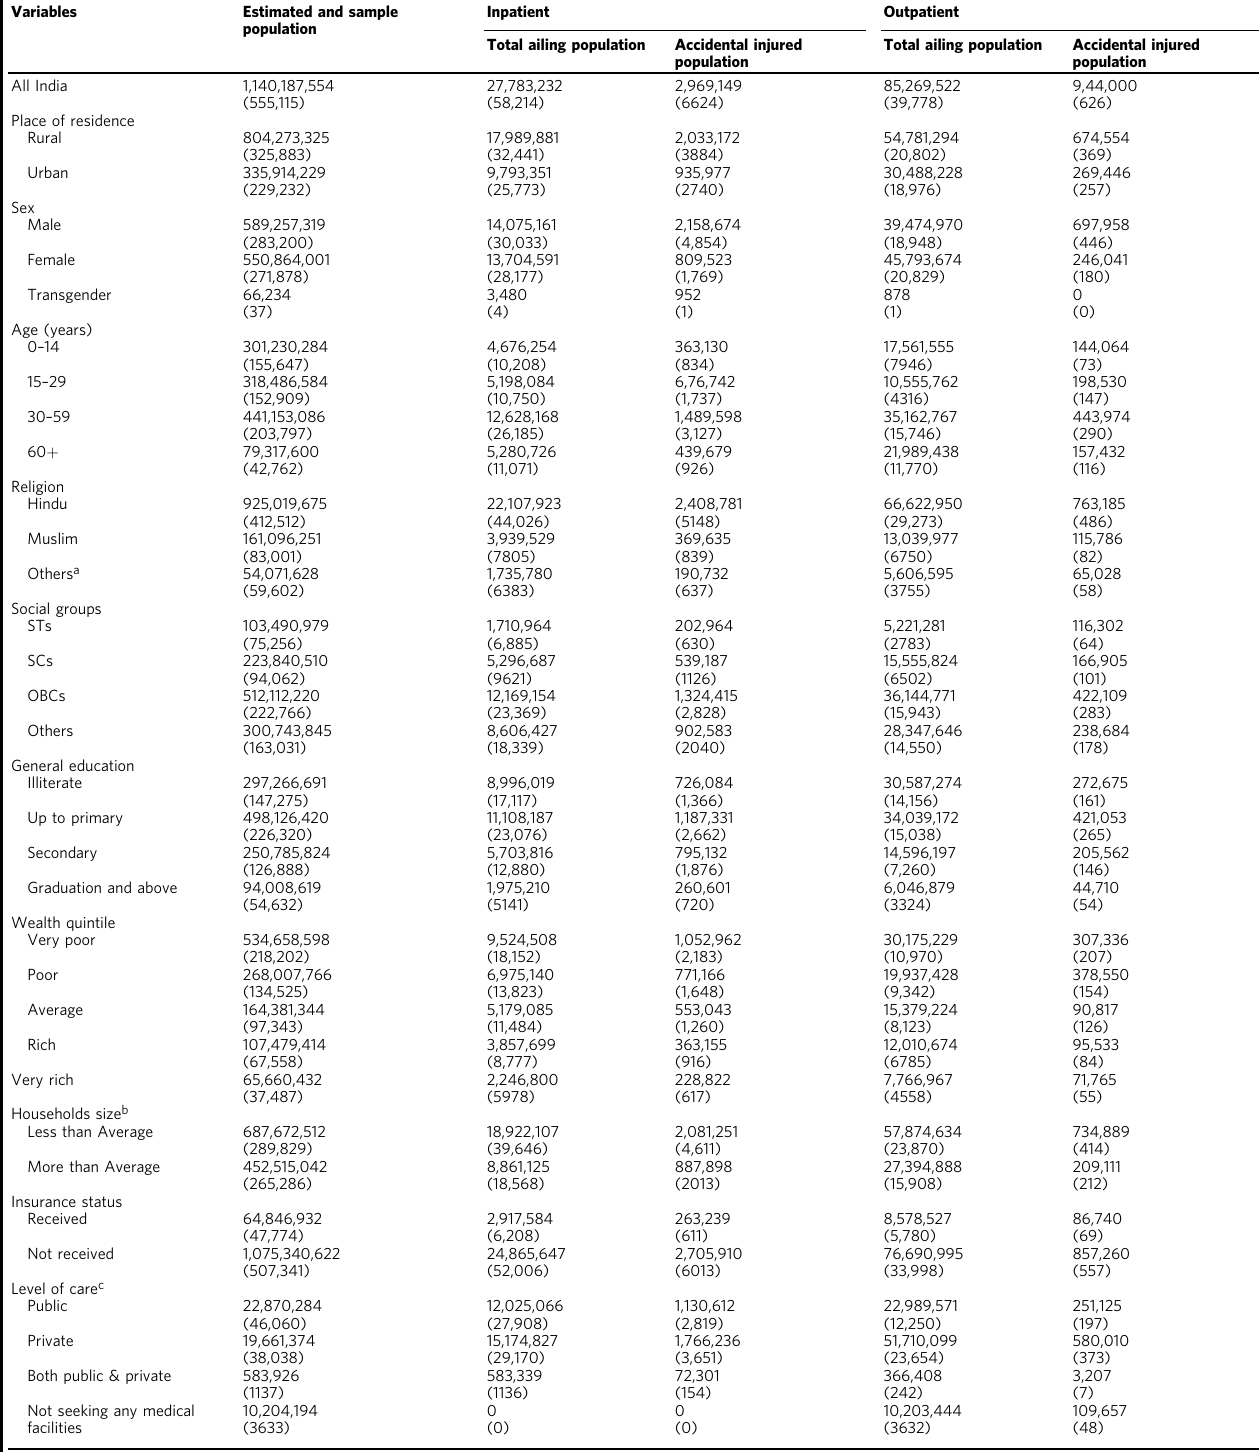
Table 2 Summary